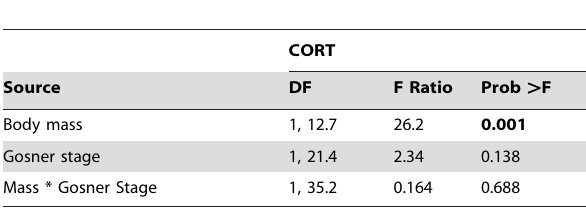
Table 3. F-statistics and P-values for the random-effects GLM of size and development associations with corticosterone (CORT) levels of tadpoles reared in